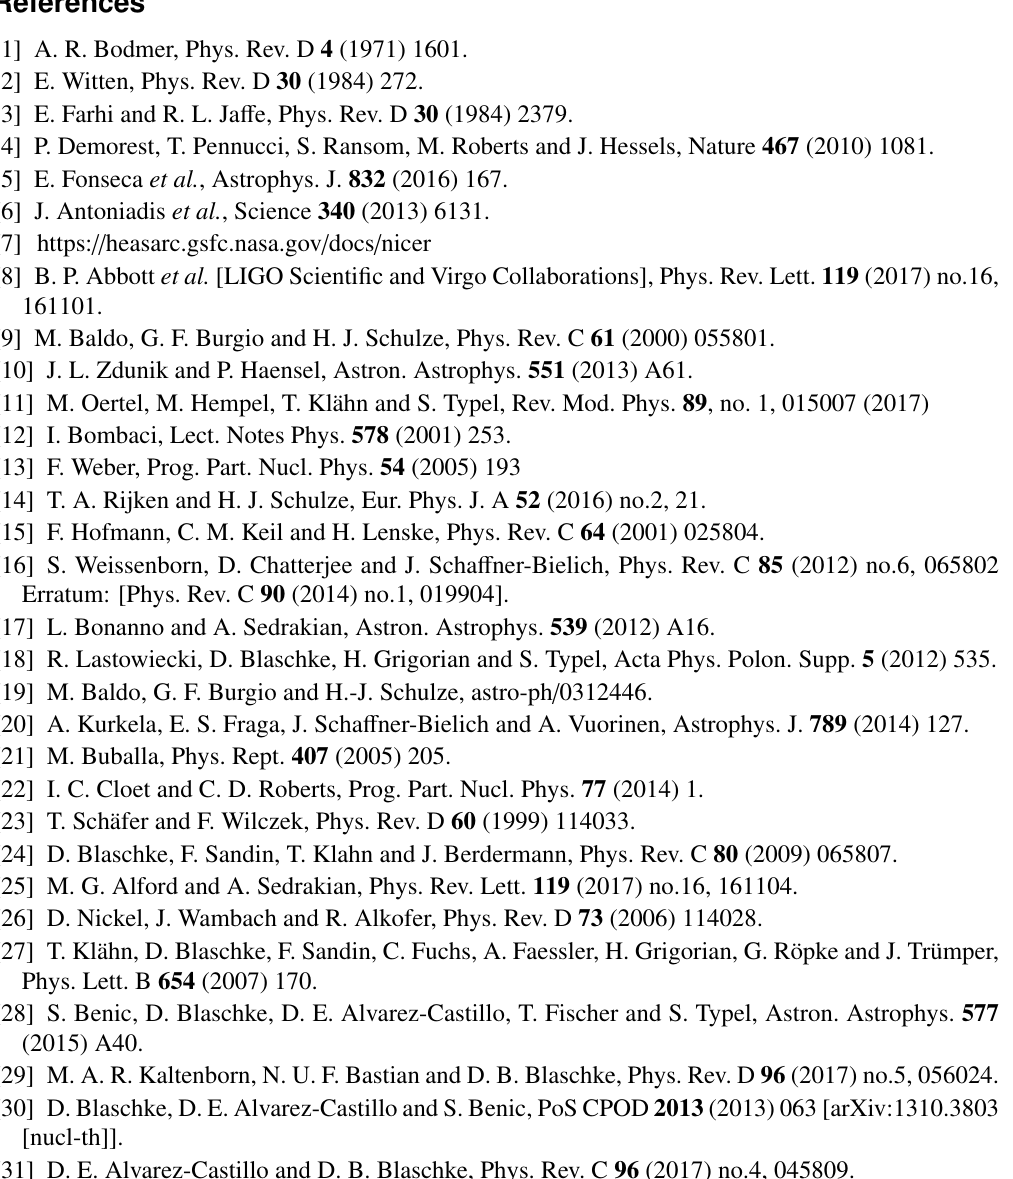
Figure 1. Energy per baryon vs.